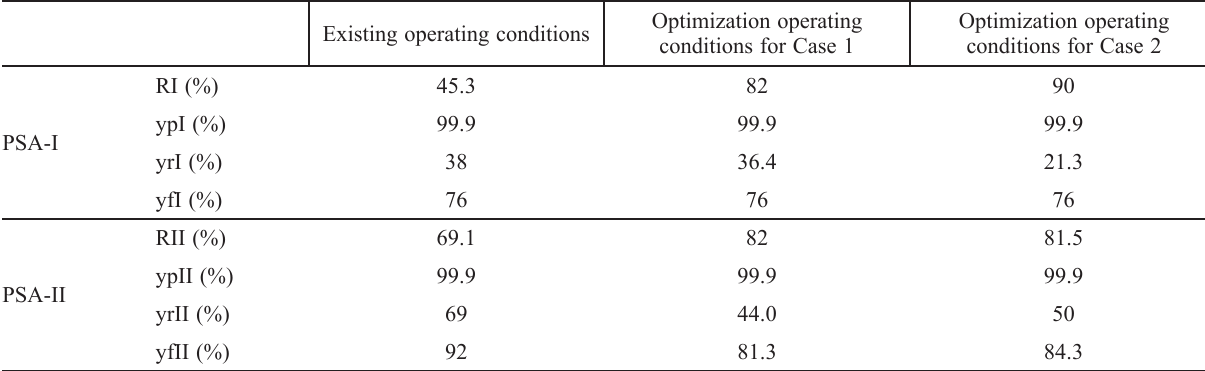
Table 7 – Result optimized for purifiers